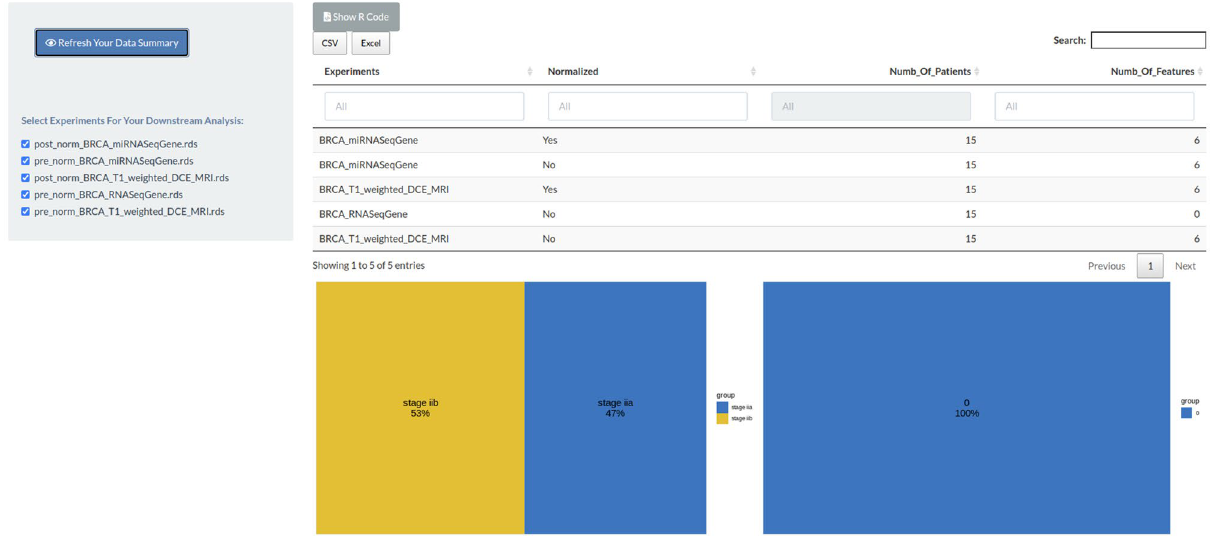
Figure 6. Data summary module. In the Summary module, a review of all available experiments is shown after the operation executed in the workflow. In this module, the user may decide to execute a downstream analysis in the next step or go back to change data selection or normalization methods. If the user decides to use a downstream analysis module, using the left checkbox list, the final experiments need to be selected as input for the next module. In this section a graphic statistic plot of clinical data is also reported. In this example, the percentage of data available after filtering is reported for tumor stage II. The figure is generated by using R software version 3.6.1 (https ://www.r-proje with specific buttons by the user. Moreover, tables and some plots are interactive and allow exploring the data more deeply. All the structures of the GUI were developed with Shiny (v1.5) 27 , Shinyjs (v1.1) 28 and Shinydash- board (v0.7.1) 29 R packages. The tables and the plots were built by DT v0.14 (a wrapper of javascript library ‘DataTables’) 30 and plotly (v4.9.2.1) / ggplot2 (v3.3.2) 31,32 , respectively.